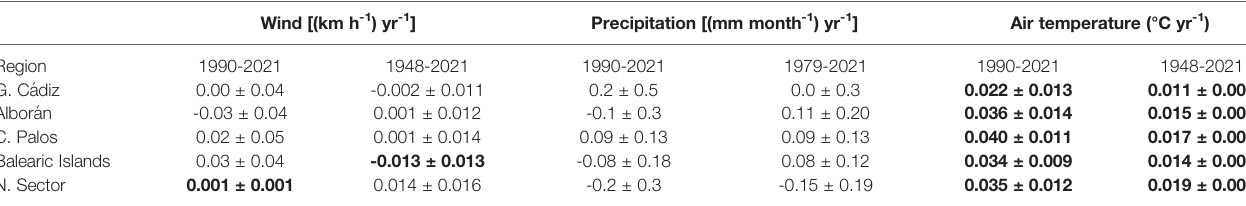
Two different periods were analyzed: 1990-2021, and the longest available period. Bold numbers indicate those results that are statistically signi fi cant.